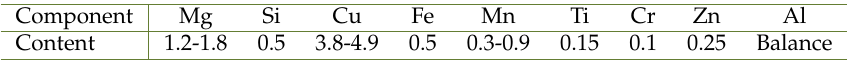
Table 1. Chemical composition of AA2024 (wt. %)